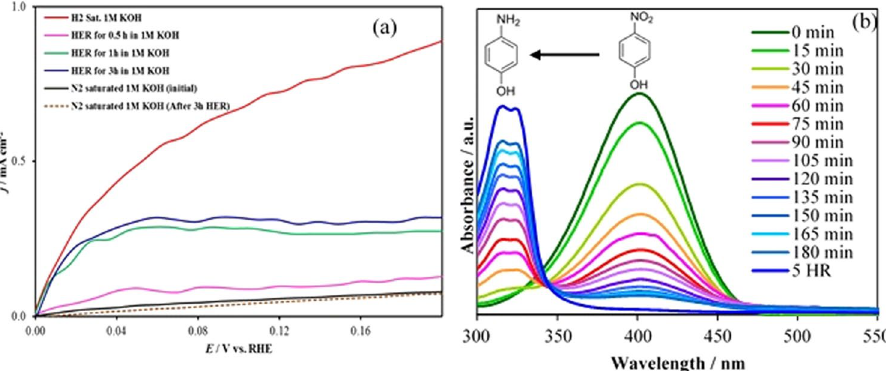
Figure 8. ( a ) Evidence of H 2 evolution was confirmed by electrochemical oxidation of hydrogen in a Pt electrode. Initially HER was performed at NiSe 2 /Au at a constant potential of − 0.2 V vs RHE for different periods of time (0.5, 1 and 3 h) under N 2 saturated and blanketed 1.0 M KOH. The evolved gas was then oxidized with Pt electrode, whereby the oxidation potential and current density confirmed the presence of H 2 . In the absence of H 2 [before HER, (black solid line) and after purging with N 2 (reddish dashed line)] the current density was very close to zero. ( b ) Catalytic hydrogenation of p-nitrophenol to p-aminophenol monitored by the change in UV-visible absorbance spectra, confirming the evolution of active